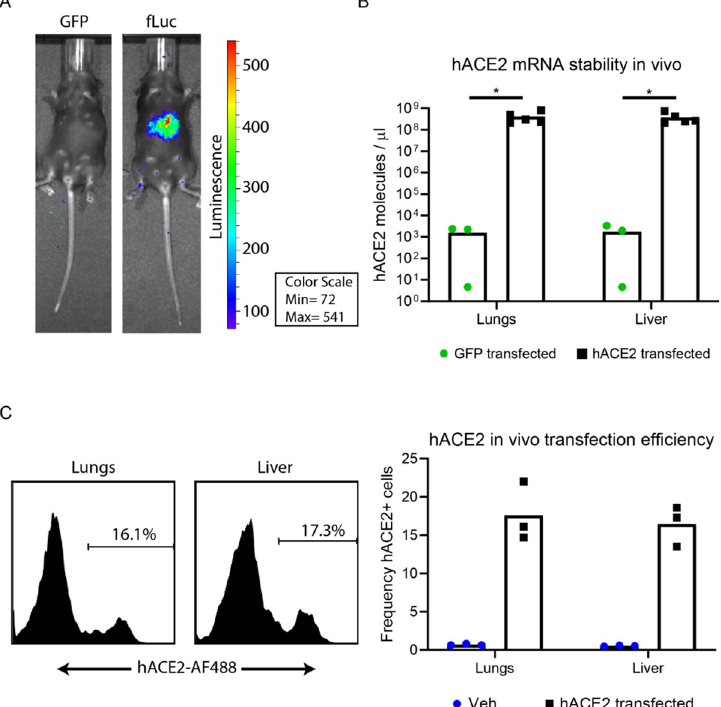
Fig 2. In vivo transfection efficiency. ( A ) fLuc reporter expression. 10 μ g of fLuc or GFP mRNA was prepared in Polyplus in vivo-jet RNA in vivo transfection reagent and administered to Ifnar 1-/- via IV and IN combination route. 24 hours following transfection, mice were injected IP with D-luciferin and imaged via IVIS 15 minutes later. ( B ) hACE2 mRNA stability in vivo. Ifnar1-/- mice were transfected with 10 μ g of GFP or hACE2 mRNA. 24 hours post transfection, mice were euthanized and liver and lung tissue homogenized in TriReagent RT for RNA extraction. hACE2 mRNA levels were quantified from extracted RNA via qRT-PCR. Statistical significance was determined by Mann-Whitney test (p = 0.03 and p = 0.03, in the lungs and liver, respectively) ( C ) hACE2 in vivo transfection efficiency, Ifnar1-/- mice were transfected with 10 μ g of hACE2 mRNA or vehicle alone. 24 hours post transfection, mice were euthanized and liver and lung tissue were dissociated into single cell suspensions and stained with a human- ACE-2 specific antibody, followed by an AF488-conjugated anti-human secondary antibody. Live cells were analyzed on an Attune focusing flow cytometer and are represented as frequency of hACE2 expressing